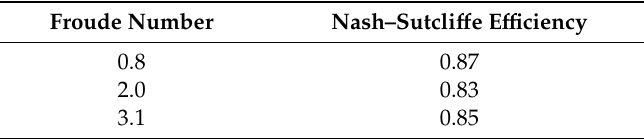
Table 10. FLOW-3D validation